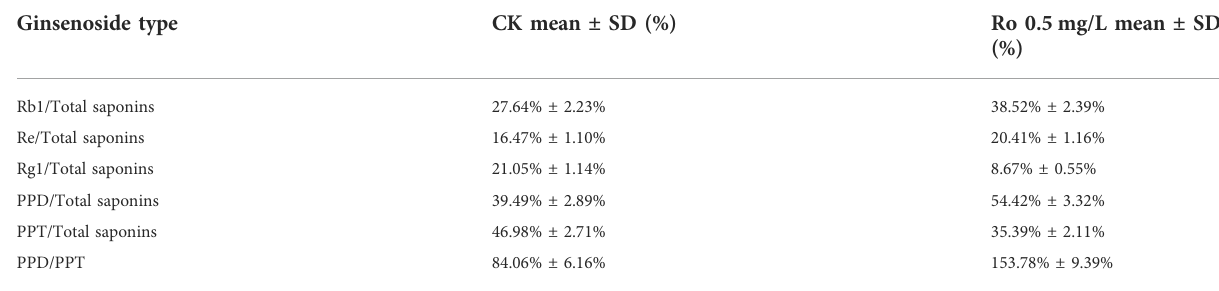
TABLE 1 Changes in the ratio of ginsenosides in hairy roots after Ro treatment. Ginsenoside